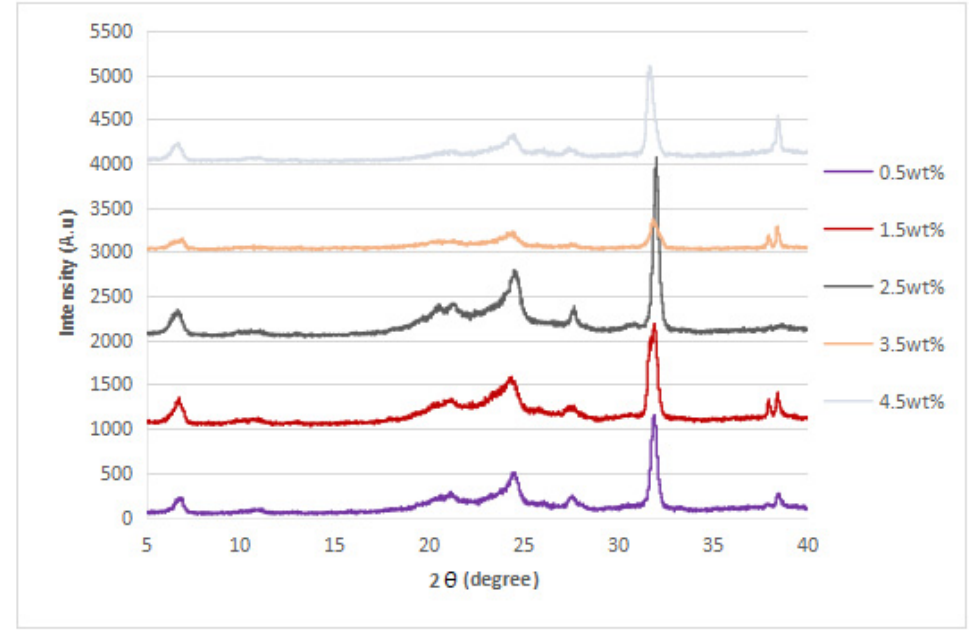
Figure 7. XRD Spectra of Nylon 610 Nanocomposites with Untreated Graphite Flakes .